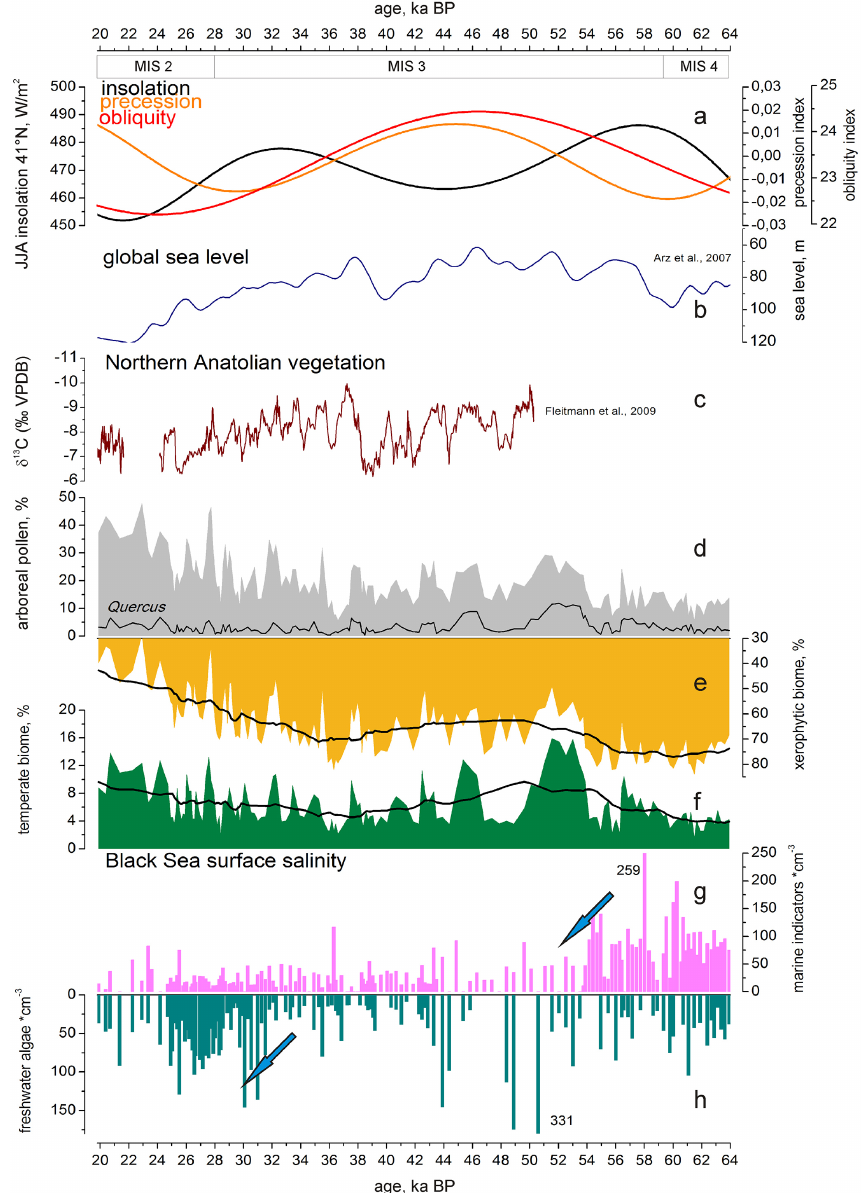
Fig. 5. Summary plot for northern Anatolian vegetation and Black Sea surface salinity in comparison to insolation and global sea level changes: (a) summer insolation at 41 ◦ N (Wm − 2 ) (mean for June, July and August), precession and obliquity indices; (b) reconstruction of the global sea level (Arz et al., 2007); together with regional data from northern Anatolia: (c) δ 13 C from Sofular Cave (Fleitmann et al., 2009) reflecting changes in C3 and C4 plants and from Black Sea core 25-GC1: (d) arboreal pollen record (%) and Quercus curve (thin line); (e) xerophytic biome (%) with smoothed curve (thick line; simple moving 20 points average) (please note the reverse scale); (f) temperate biome (%) with smoothed curve (thick line); (g) concentration of marine dinocysts and acritarchs (specimenscm − 3 ); (h) concentration of freshwater algae (specimenscm − 3 ). Blue arrows indicate two major freshening phases of the Black Sea surface. Marine isotope stages are indicated following Shackleton